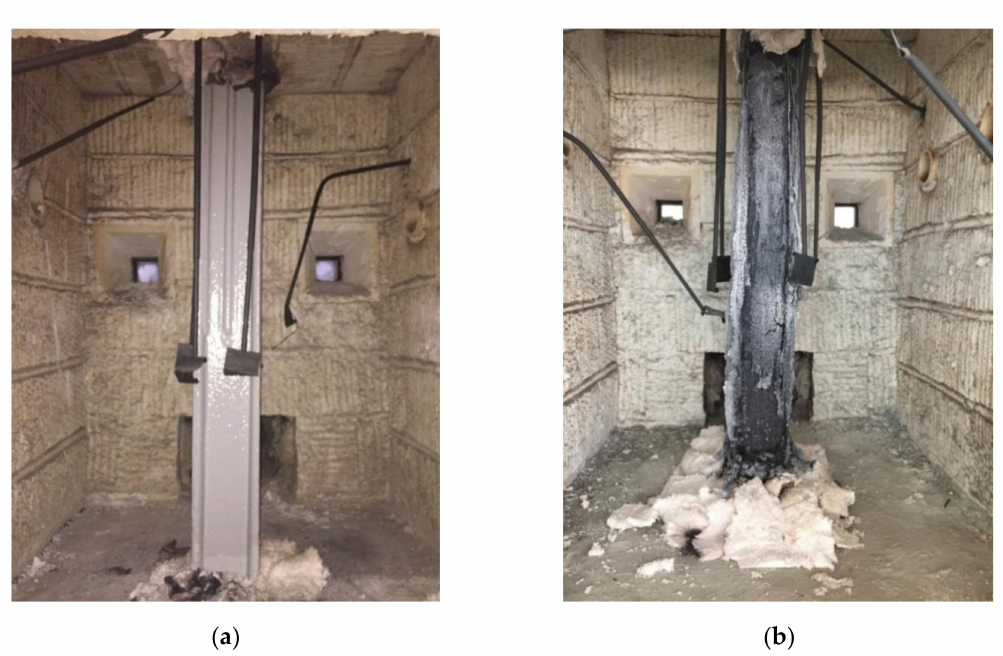
Figure 7. The external appearance of the coatings for Specimen 10: ( a ) before the tests; ( b ) after the